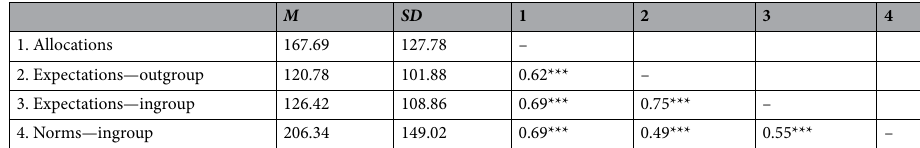
Table 1. Means (M), standard deviations (SD) and correlations between allocations to collective account, expectations of others’ allocations to this account, and prescriptive norms (Study 1). *** p <